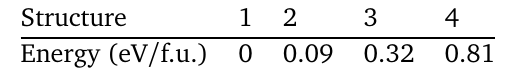
Table 2: Relative energy of the structures in Figure